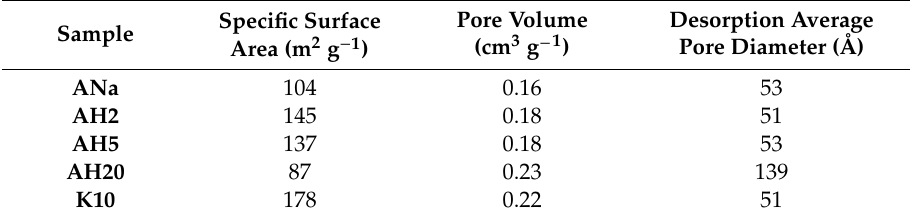
Table 4. Textural properties of the clay mineral